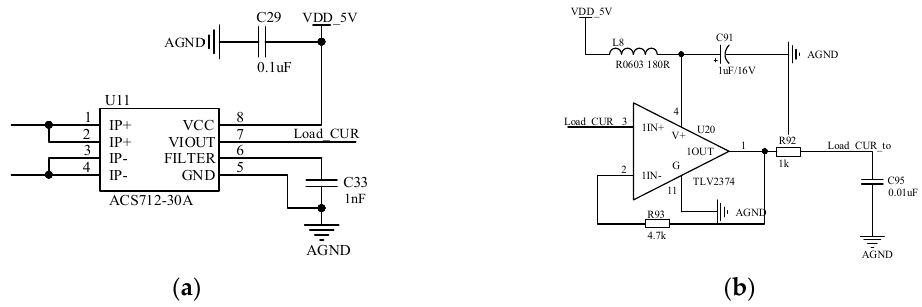
Figure 6. Current collecting and conditioning circuit: ( a ) Load current acquisition circuit; ( b ) Signal conditioning circuit.